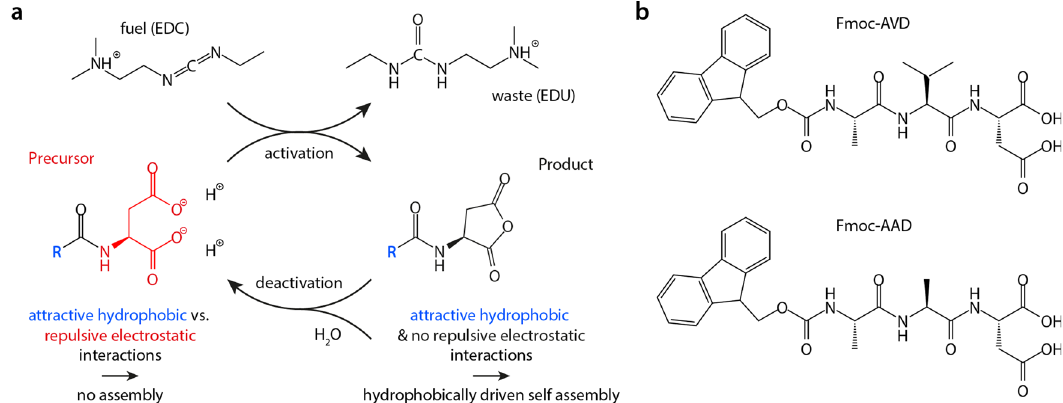
Fig. 1 Schematic illustration of the reaction cycle and peptide precursors used in this study. a In the activation reaction, aspartic acid derivatives of the precursor peptide react in the presence of a suitable fuel (here: EDC) and are converted into their corresponding anhydride product; at the same time, a waste product (here: EDU) is generated. In the deactivation reaction, the aspartic acid anhydride derivative is hydrolyzed again. Through the correct design of the Fmoc-peptides, attractive and repulsive forces can be balanced such that a hydrophobically driven self-assembly process is enabled — but only in the product state. Hydrophobic sidechains are depicted in blue and anionic ones in red. b Structural formula of the two synthetic Fmoc-peptides